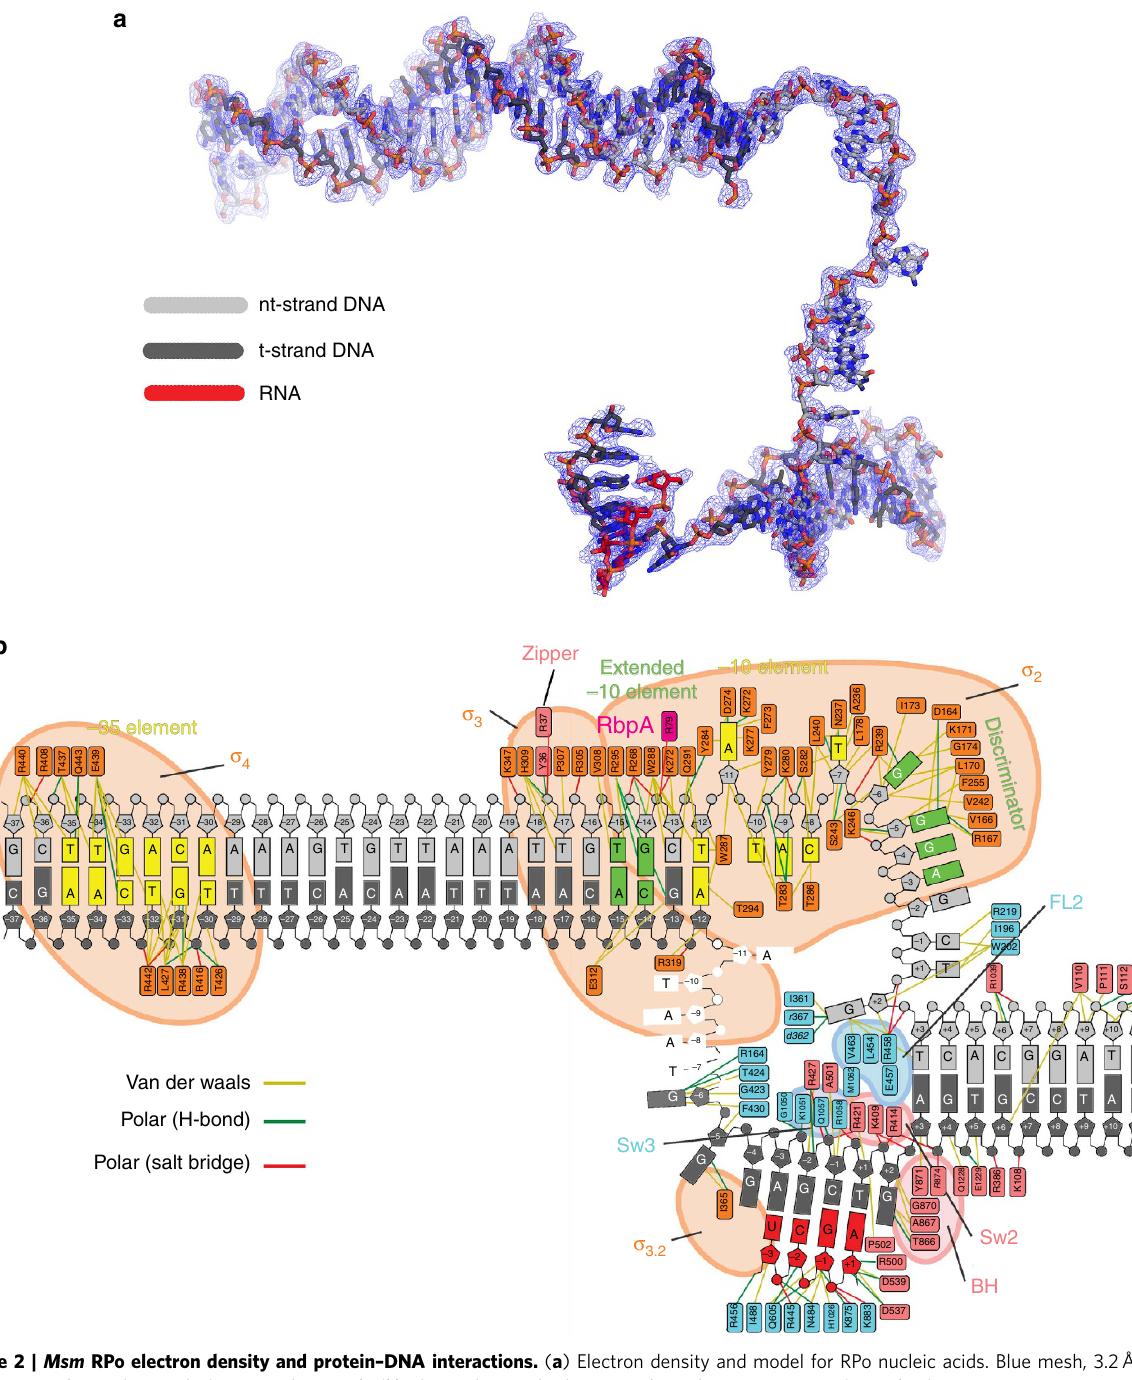
UP-element-like sequences are enriched in Mtb promoters . The DNA (Fig. 3c–e). Finally, Eco a CTD D259 and E261 have been striking similarities between Eco and Msm a CTD structure and shown to facilitate UP-element function by interacting with s 70 DNA interactions (Fig. 3) raises the possibility that a CTD/UP- R603 (ref. 26); all of these residues are conserved in the Msm element interactions play a role in mycobacteria transcription and Mtb proteins ( a CTD D253/D255, Fig. 2e, and s A R457) but regulation. To further explore this idea, we used RNA-seq with do not interact due to the non-physiological position of the a CTD. transcriptional start site (TSS) mapping data to compare NATURE COMMUNICATIONS|8:16072|DOI: